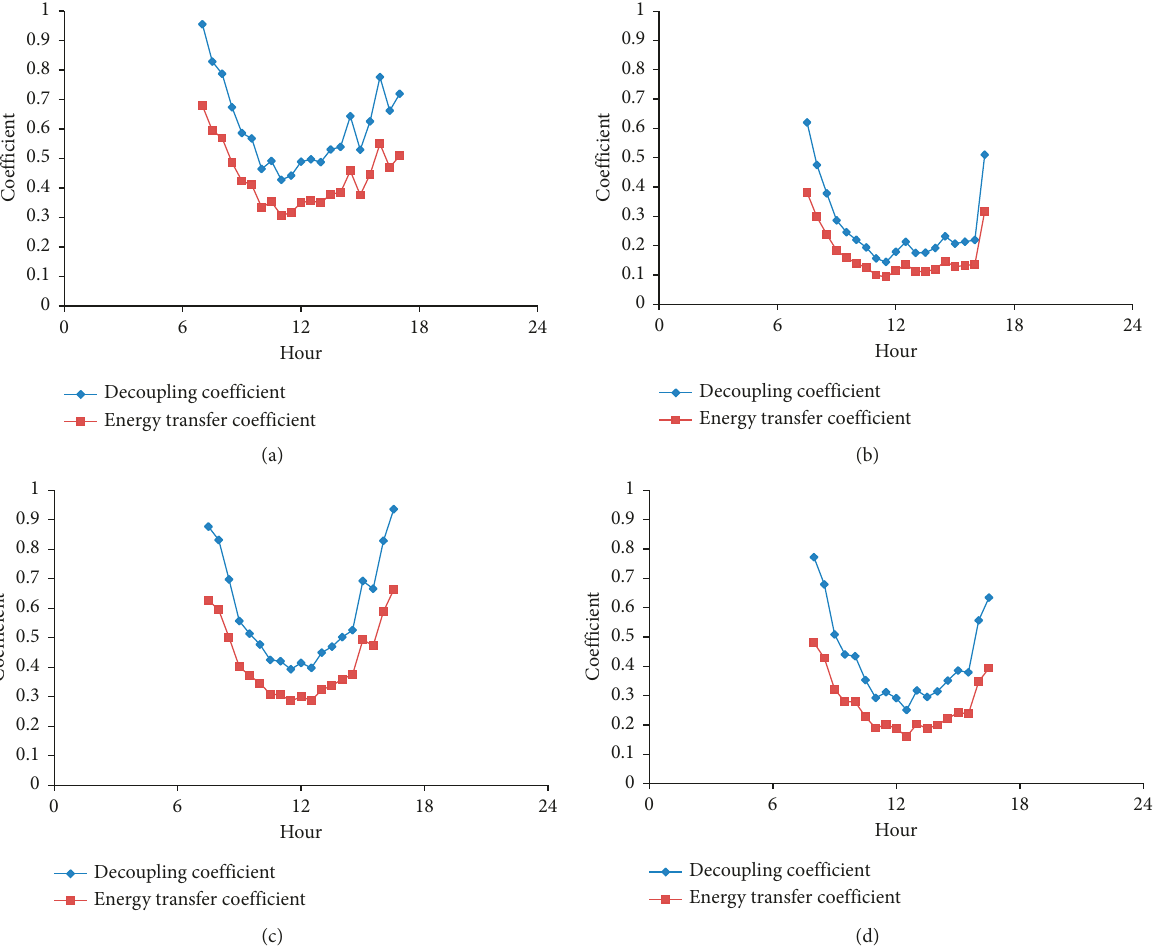
Figure 10: Diurnal variations of decoupling coefficient and energy transfer coefficient for the season of (a) warm 2005, (b) cool 2005, (c) warm 2006, and (d) cool 2006.